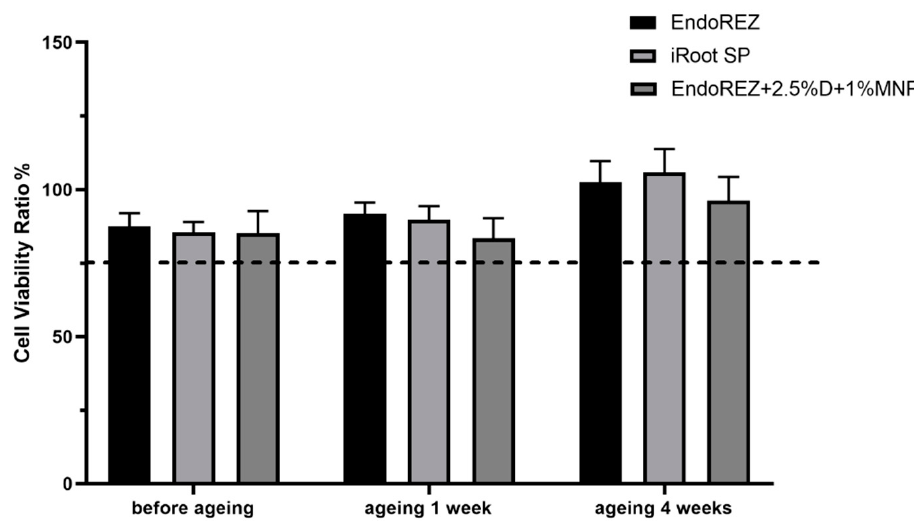
Figure 5. Cytotoxicity assay of sealer eluents with fibroblast ( n = 6). Every value is shown as mean ± SD; * p <